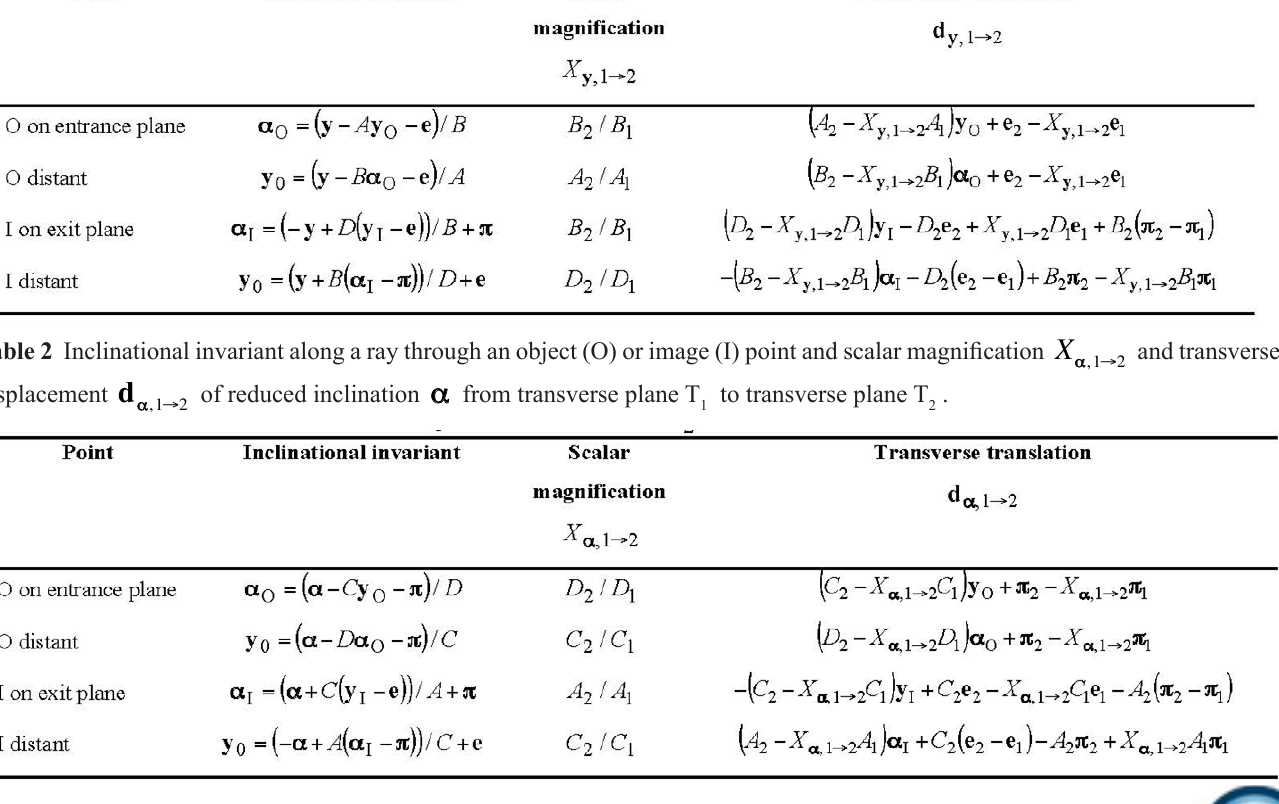
and transverse y ,1 → 2 to transverse plane T . 1 2